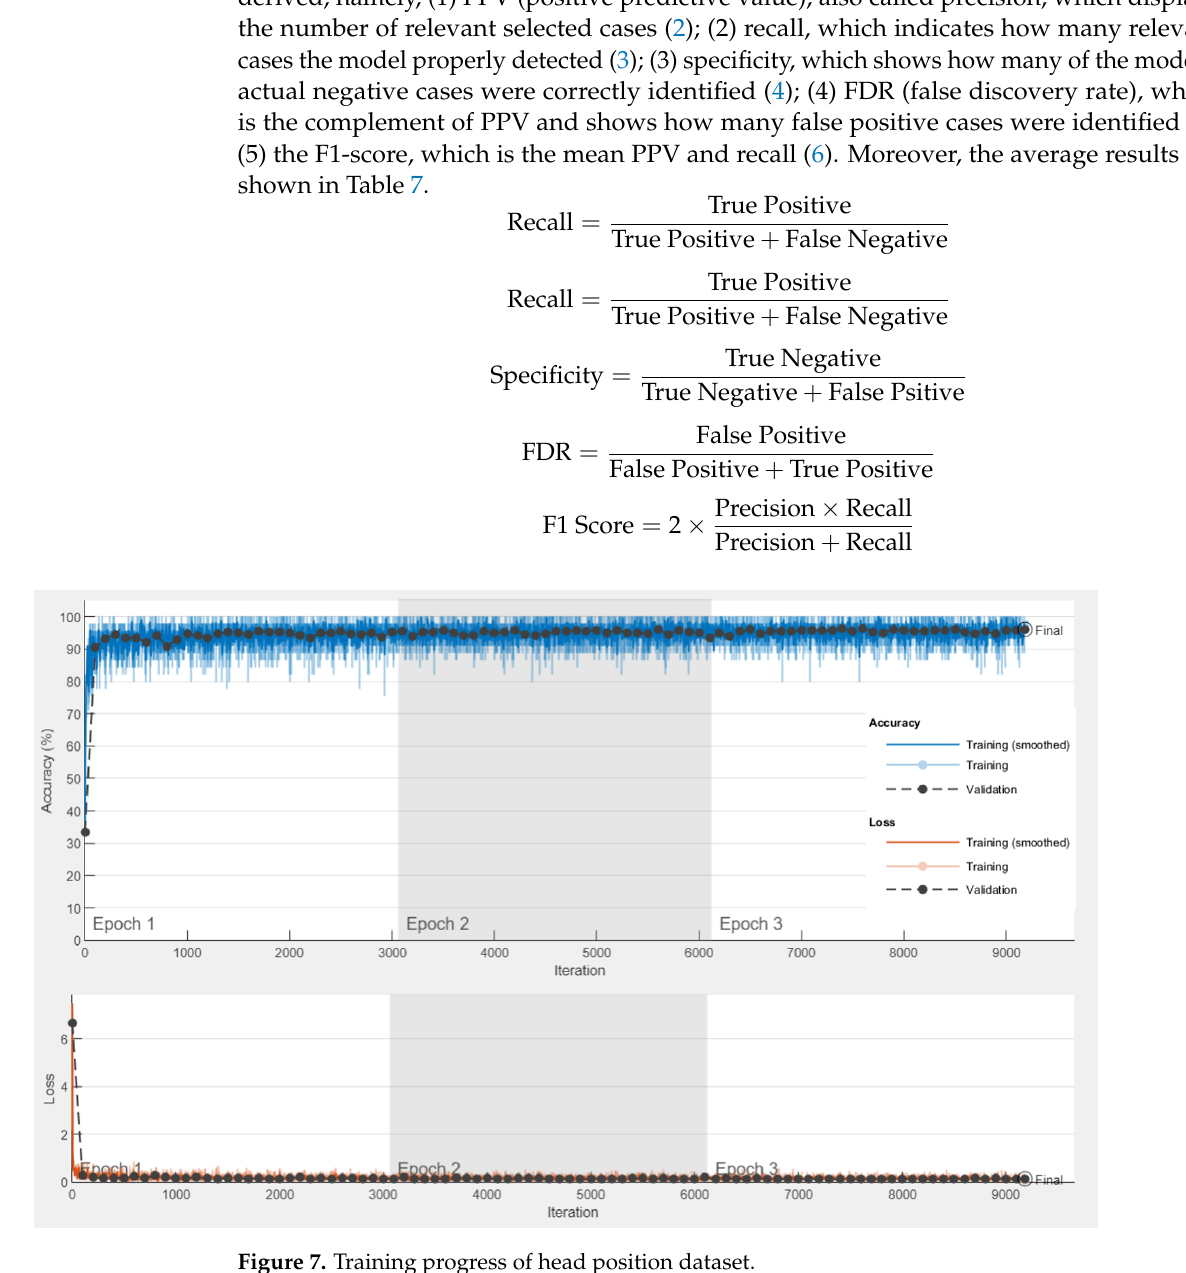
Figure 7. Training progress of head position